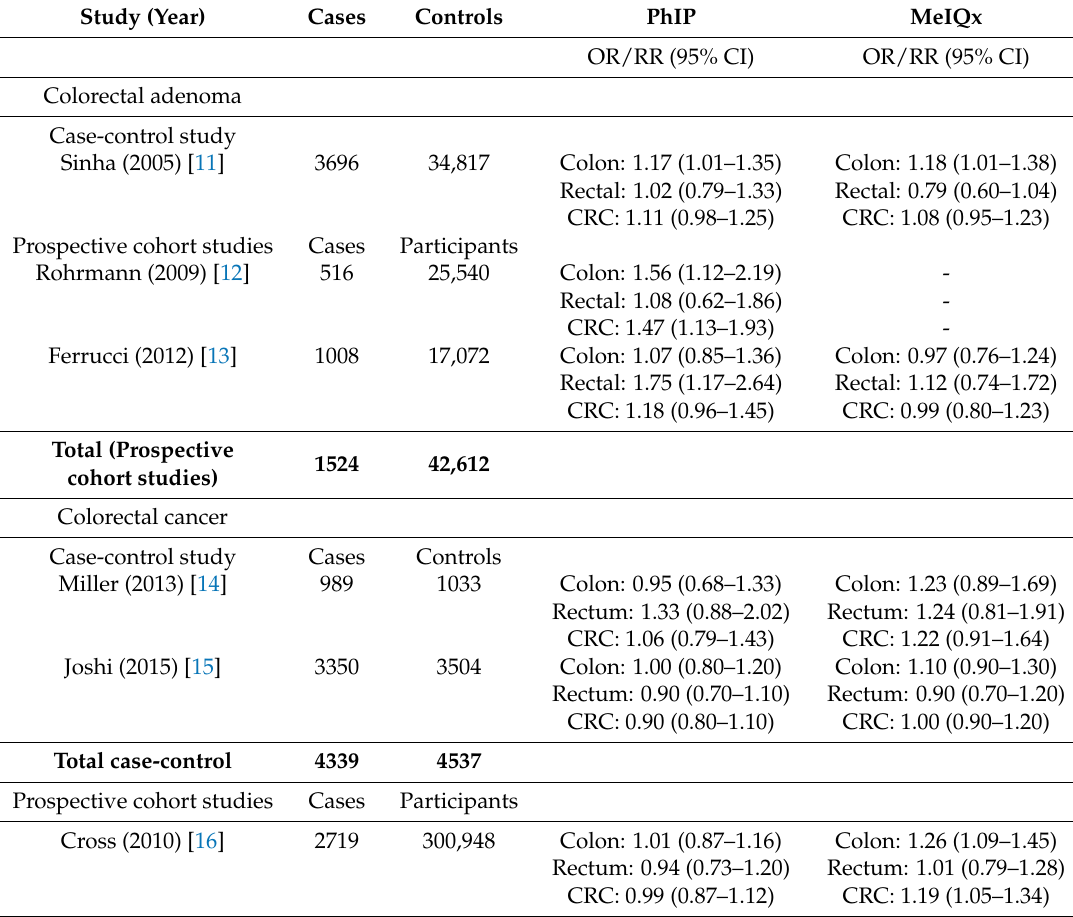
Table 2. Possible repeated examinations of OR/RR (95%